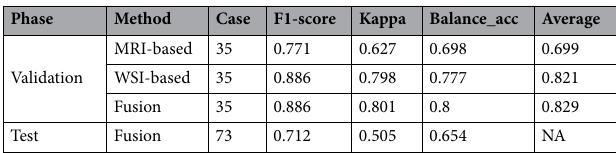
Table 1. Performance of two approaches and the scheme of label agreement.